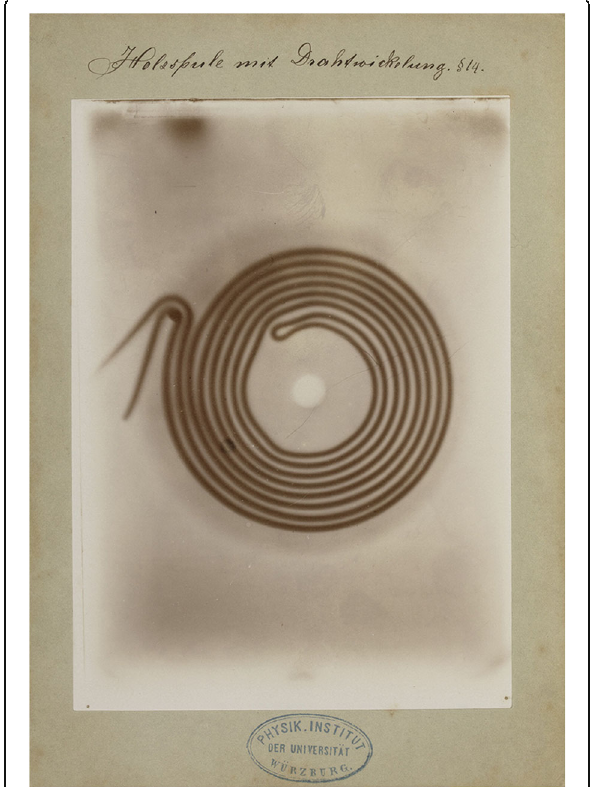
Fig. 7 Strips of zinc that have been soldered together and subsequently rolled out to a uniform thickness. This image shows faint shadows where the soldering took place which shows that the difference in atomic number and density between the zinc and the soldering (consisting of tin and lead) is enough to show up on the radiographic image although the thickness is the same everywhere. Manually written legend: ‘ Vier verlöthete und nachher ausgewalste Zinkstreifen ” (four zinc strips soldered together and afterwards rolled out into one plate). Paragraph referral: §